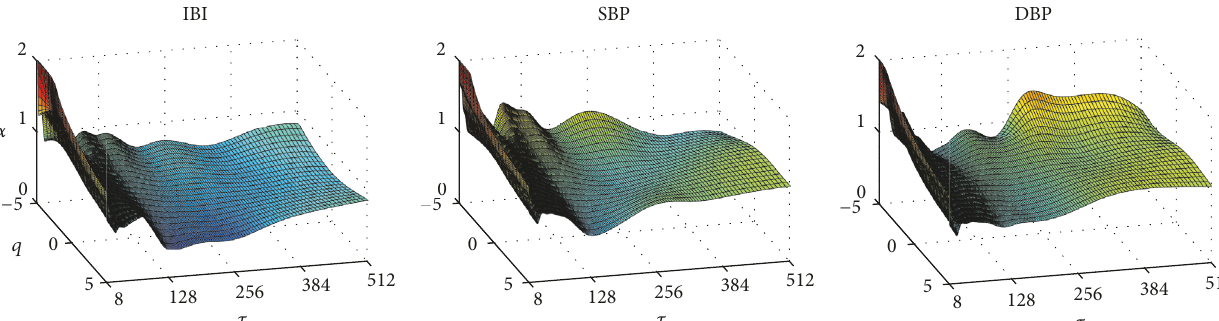
Figure 3: Example of multifractal and multiscale coefficients , 𝛼(𝑞,𝜏) , for IBI, SBP, and DBP . Data recorded in a male, normotensive volunteer. In this example, 𝛼(𝑞,𝜏) of IBI decreases steeply with 𝜏 at scales shorter than 16s, from values typical of fractional Brownian motions (𝛼 > 1) to values typical of fractional Gaussian noises (𝛼 < 1) . Even if 𝛼 is lower than 1 at larger scales, the 𝛼(𝑞,𝜏) surface is not flat and a relative maximum appears at 𝜏 = 32 s, more pronounced for positive rather than for negative q values. SBP differs remarkably from IBI: 𝛼 tends to be greater at scales > 64s, and pronounced local maxima appear when 𝑞 < 0 . DBP differs from IBI and SBP: 𝛼(𝑞,𝜏) increases at 𝜏 > 128 s for any q , reaching values greater than 1; and no local maxima appear at 𝜏 < 128 s.